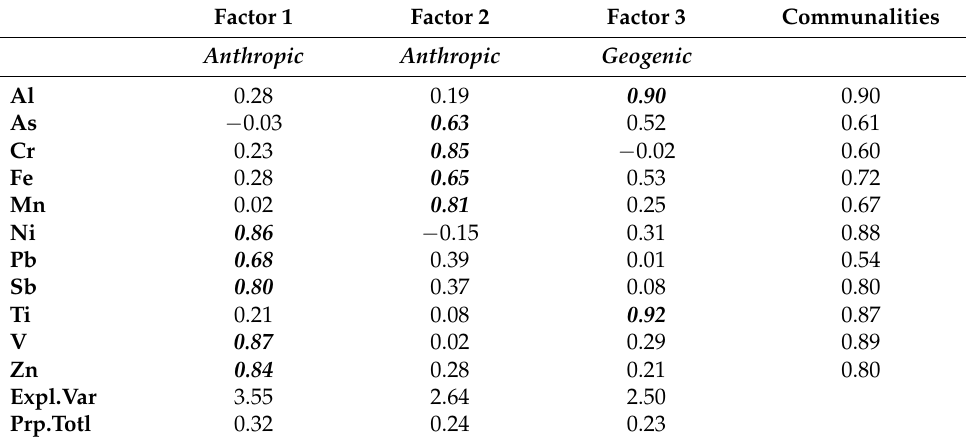
Table 3. Factor loadings (Varimax rotation) for the lichen samples from the Syracusan petrochemical complex ( p < 0.05). Factor 1 Factor 2 Factor 3 Communalities Anthropic Anthropic Geogenic Al 0.28 0.19 0.90 0.90 As − 0.03 0.63